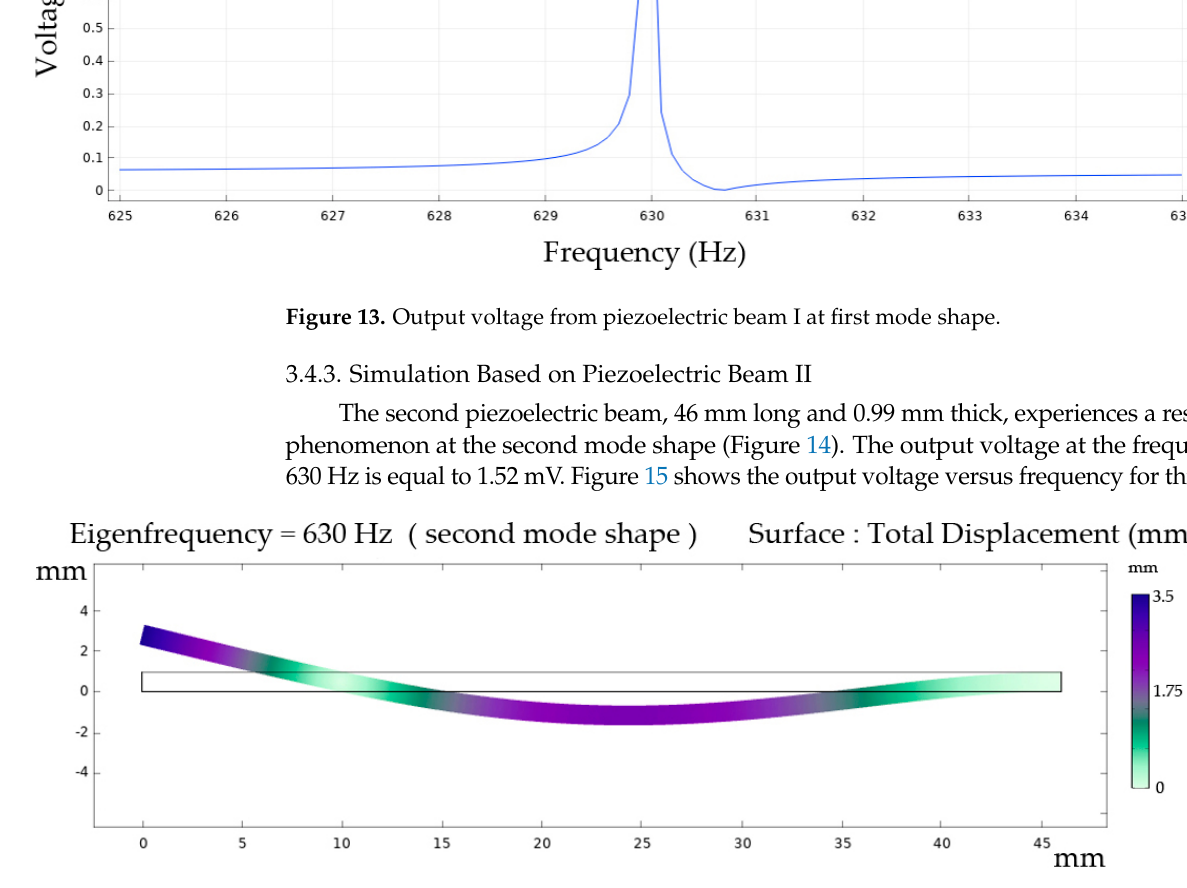
Figure 14. Second mode shape of piezoelectric beam II.